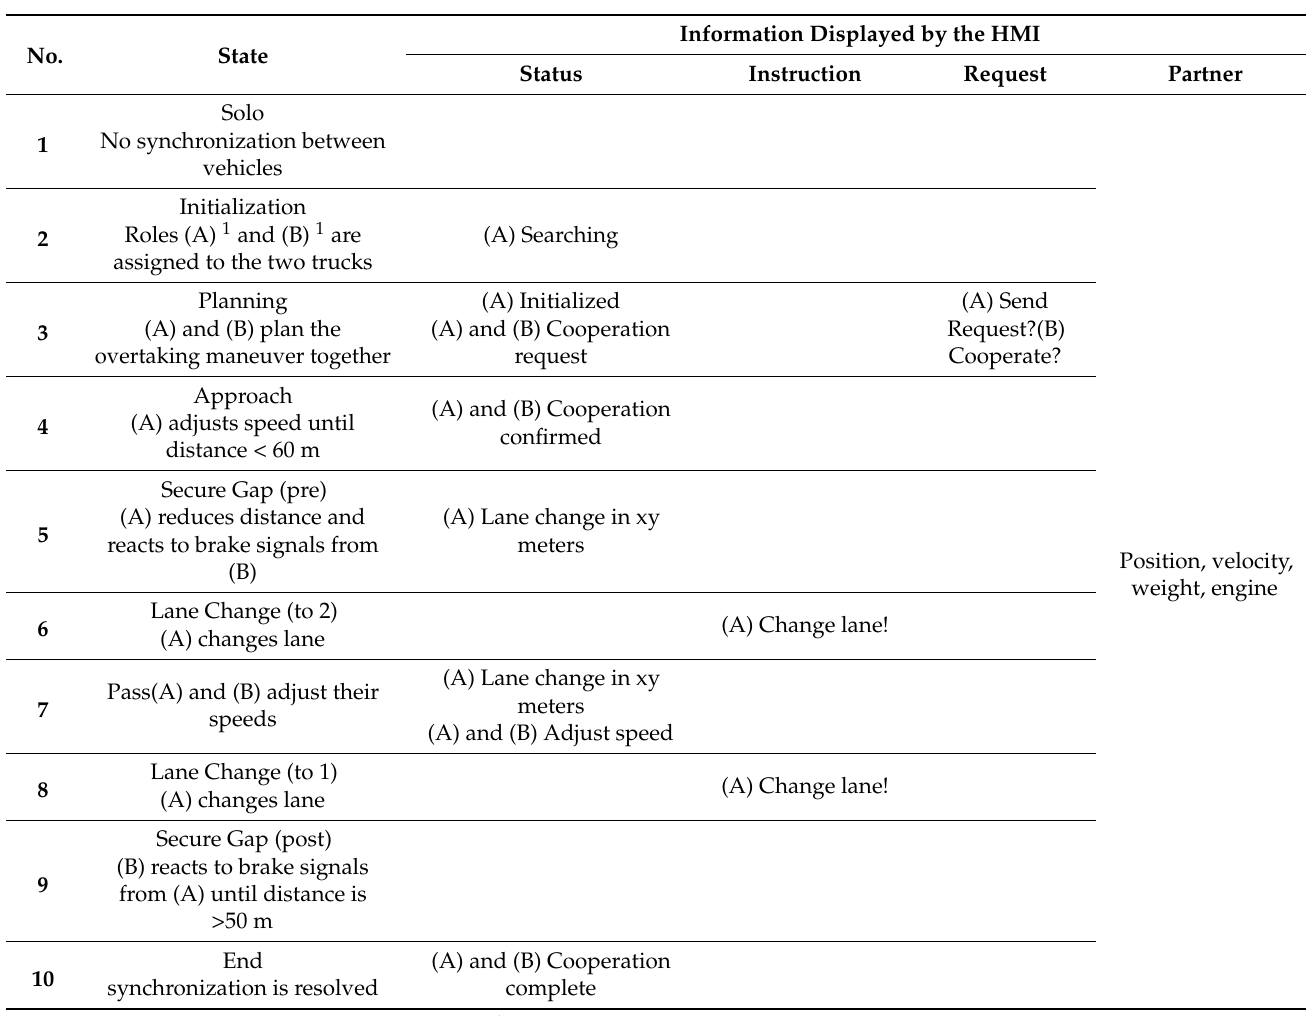
Table 1. Description of the ten states of cooperative truck overtaking maneuvers on freeways (according to [8]), with the corresponding information displayed by HMI (according to [9]).